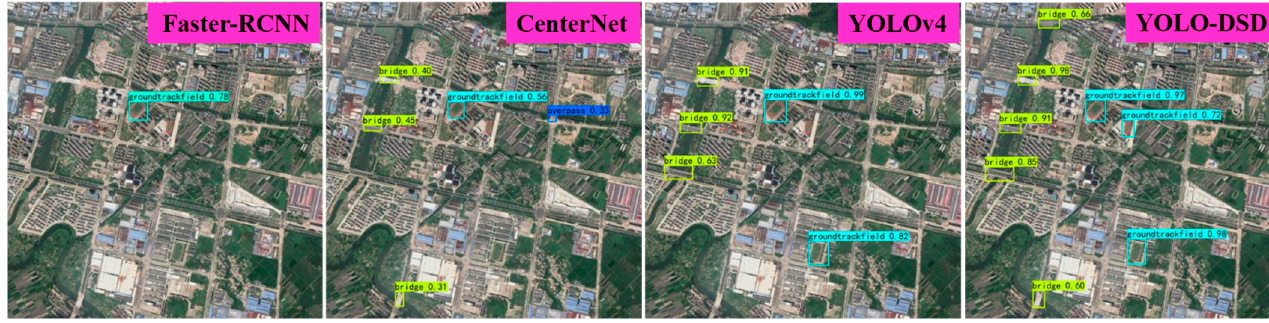
Figure 15. The detection result of small-sized instance.